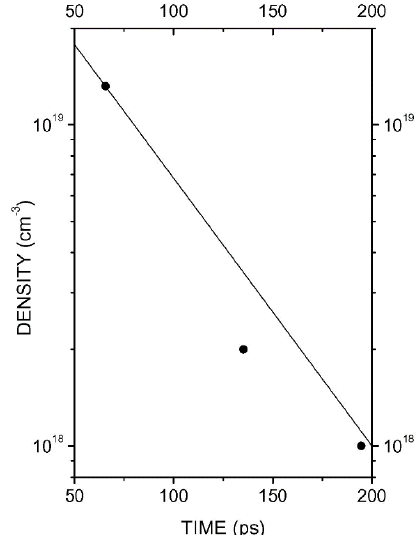
Figure 12. Evolution of the photoinjected carrier concentration in the same conditions of Figure 11, governed mainly by ambipolar